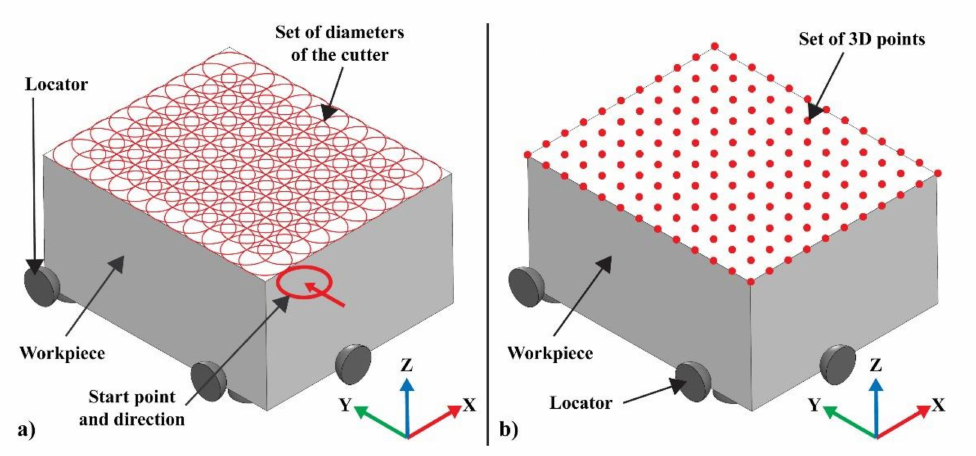
Figure 3. ( a ) Set of diameters of the cutter during the milling, ( b ) skin model shape of a milled plane.